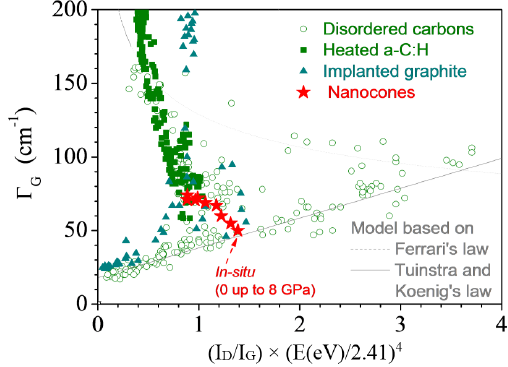
Figure 16. Г G vs. I D / I G plot for a large variety of disordered graphitic samples. Grey lines are obtained from a fit (more explanation in the work of Pardanaud et al. [66]. Data obtained from disordered carbons (514 and 325 nm data) were also obtained from this paper. Data of implanted HOPG (triangles) were taken from [230] and from [231], respectively, and those of thermally heated amorphous carbons were taken from [225]. Data belonging to nanocones under high pressure are given in green stars, and were extracted from [223].